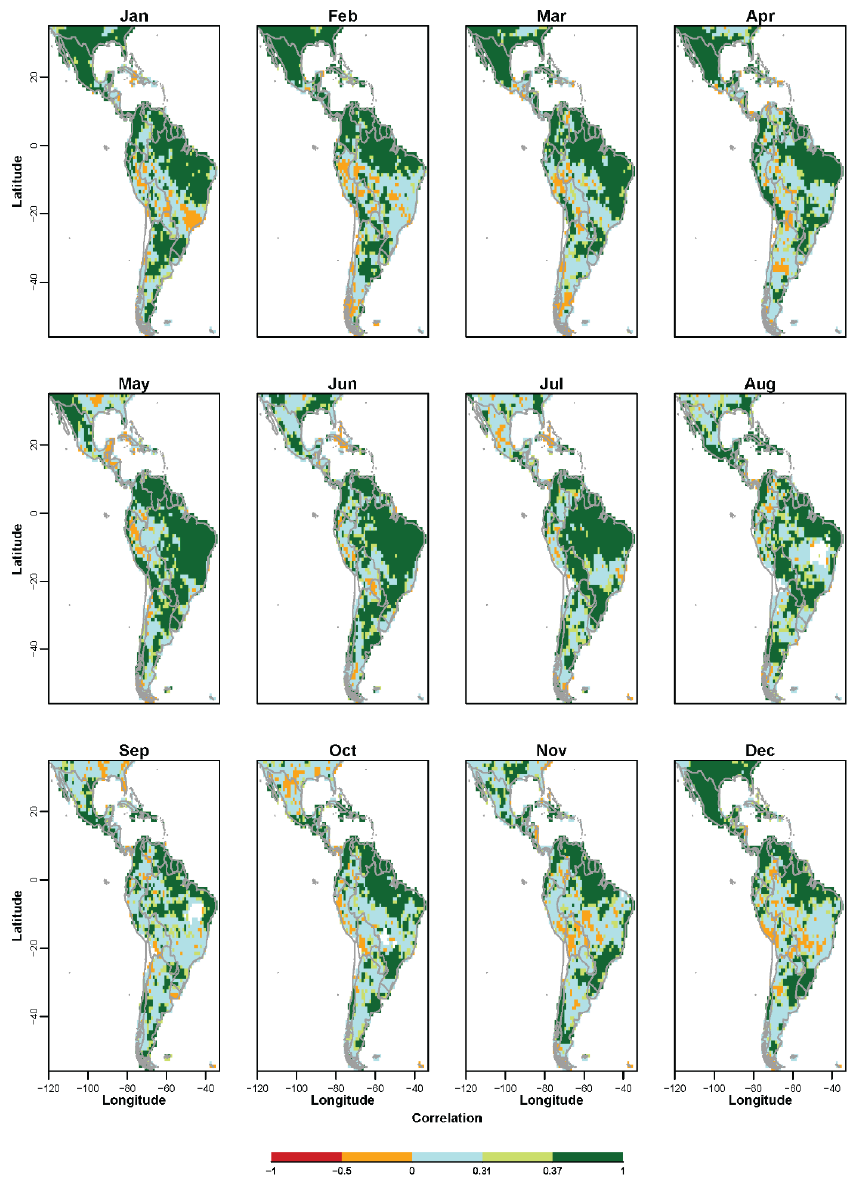
Figure 1. Monthly correlation of the observed and forecast standardized precipitation index (SPI) at 3-months lead time (SPI3) (using the mean of the ensemble) for the hindcast period (1981–2010). Values are indicated in the color bar: 0.31 (0.37) is statistical significant at 10% (5%) significance level. Interestingly, scalar skill score results suggest that SPI3 forecasts match the observations in dry regions mainly during the beginning of the dry seasons, while at regions with high rainfall variability and/or during the wet seasons the forecasts are usually less skillful. Therefore, we believe that the ECMWF S4 ensemble mean might underestimate monthly rainfall and thus increase the intensity of dry periods and lessen the forecast values of SPI3 for the study region.